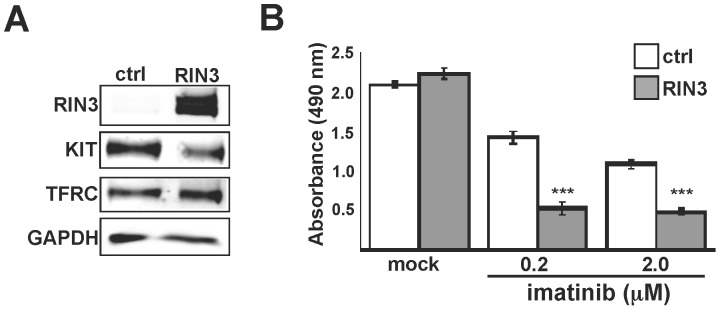
RIN3 over-expression sensitizes mastocytosis cells to imatinib. (A) HMC1.1 cells infected with empty vector (ctrl) or RIN3 lentivirus were incubated with increasing amounts of Imatinib for 24 hours. (B) The graph represents MTS assay results for cell viability. Assays were performed in quadruplicate, ***p<1 × 10−5.